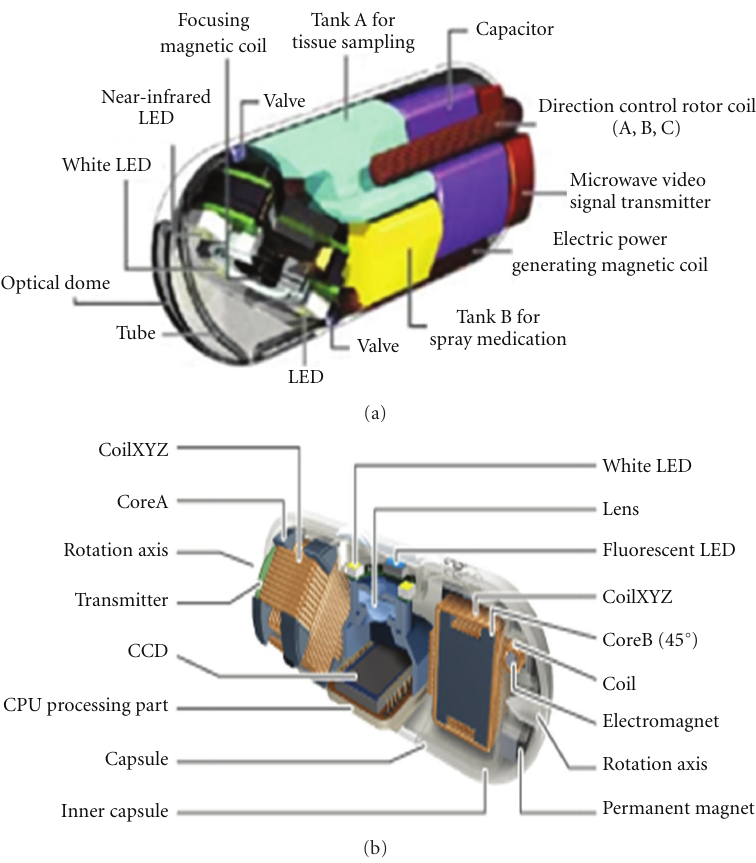
Figure 5: Architecture of the (a) Norika and (b) Sayaka capsule